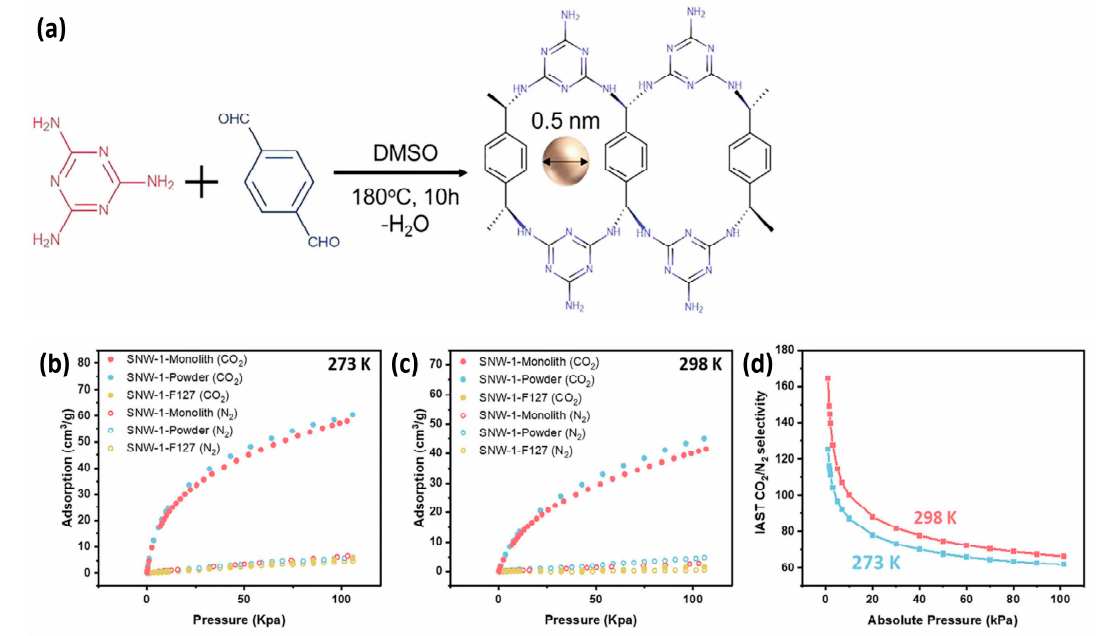
Figure 13. ( a ) SNW-1 COF monolith synthesis procedure using melamine and terephthalaldehyde; ( b ) CO 2 and N 2 adsorption curve of SNW-1 monolith, SNW-1 powder, and SNW-1/F127 monolith at ( b ) 273 K and ( c ) 298 K; ( d ) sorption selectivity of CO 2 over N 2 SNW-1 monolith by IAST calculation [55].